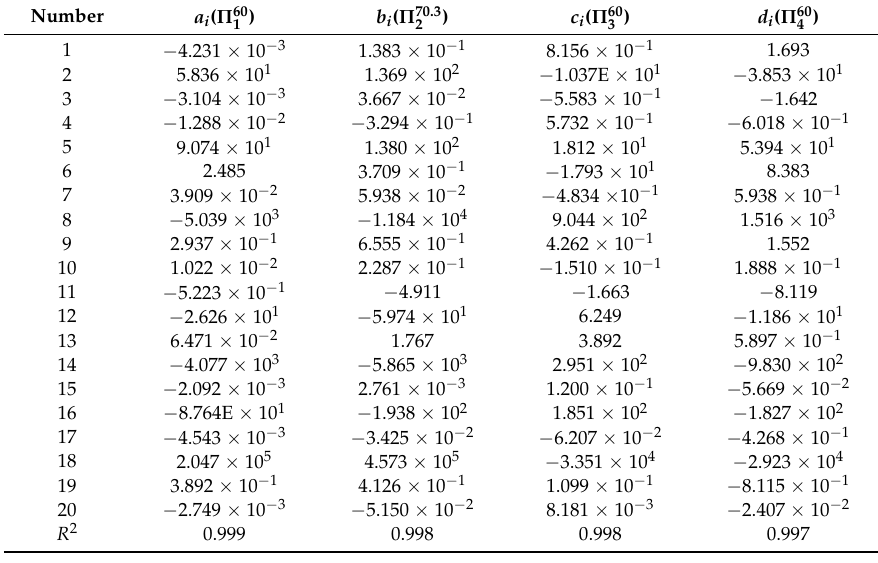
Table 2. Fitting parameters of the four dimensionless functions, Π 60 Equations (11)–(14).